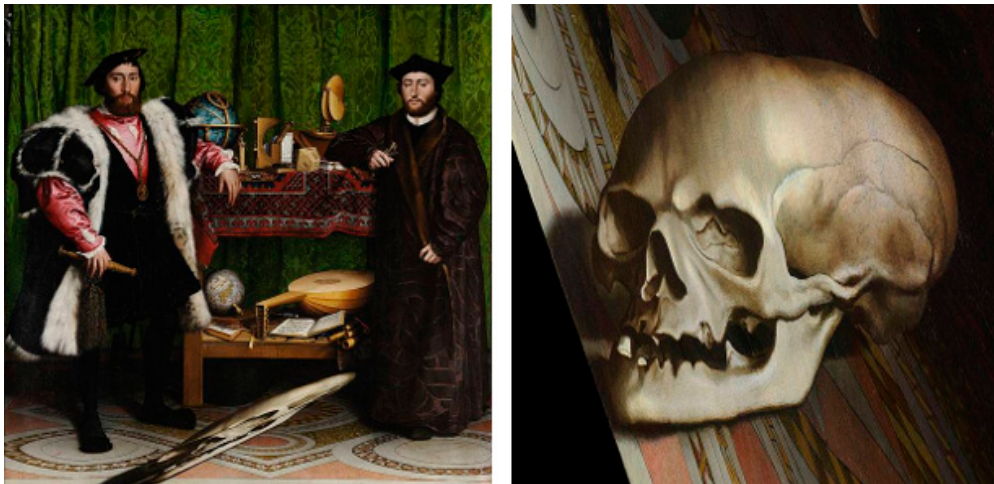
Figure 2. The Ambassadors by Hans Holbein, 1533. Oil on oak, 207 x 209.5 cm. The National Gallery , London. Image reproduced with permission (left). Digitally reprojected image of the anamorphic skull in the bottom center of the painting. The imperfections evident in the left eyesocket may have been due to the need to move or refocus the optics halfway through. Image permission: courtesy Thomas Shahan, https://commons.wikimedia.org/wiki/File:Holbein_Skull.jpg. (right)